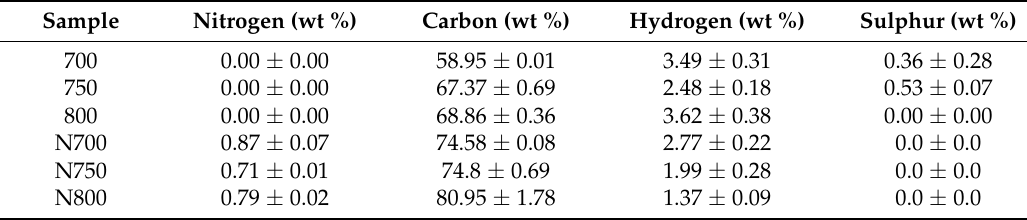
Table 3. Textural properties of the synthetized samples from Sargassum spp.